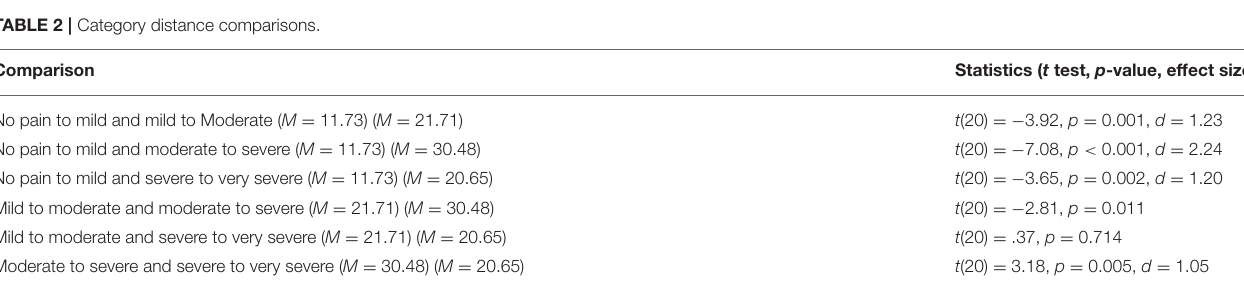
TABLE 2 | Category distance